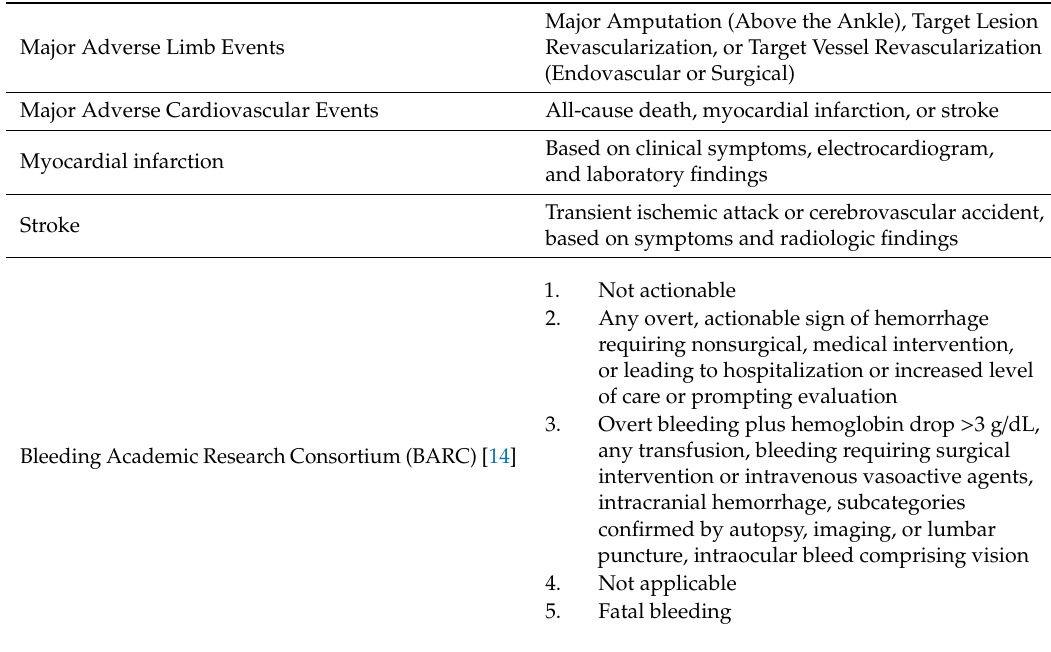
Table 1. Definitions of the end